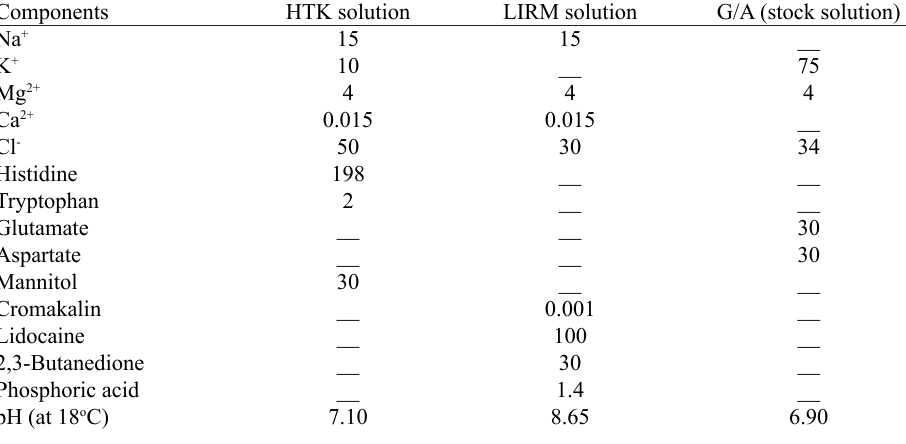
Table 1. Compositions of the tested cardioplegic